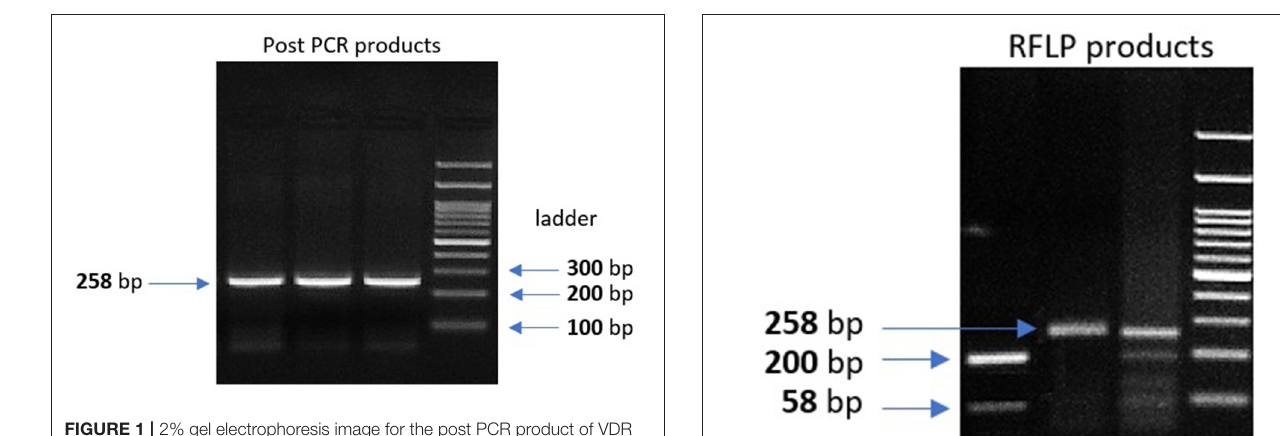
FIGURE 1 | 2% gel electrophoresis image for the post PCR product of VDR fok1 gene, Lanes 1, 2, 3: VDR fok1 amplification at 258 bp, Lane 4: 100 bp DNA Ladder.